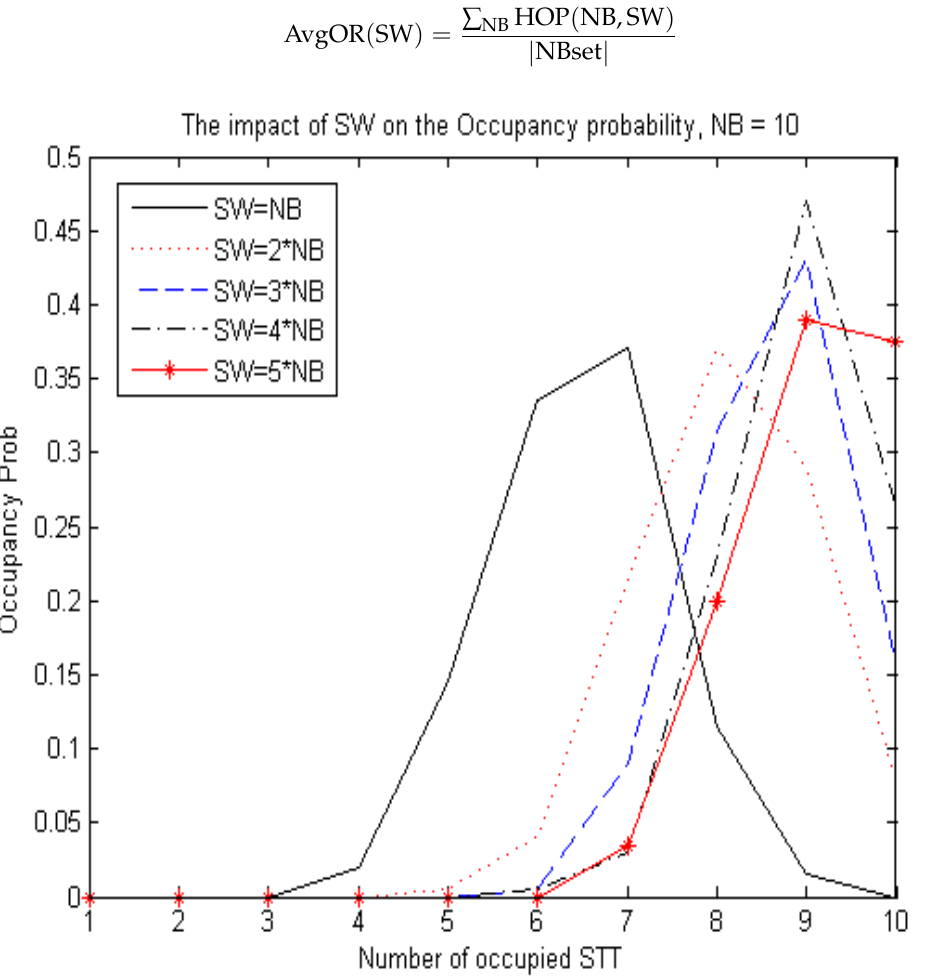
Figure 3. Impact of the SW size on the occupancy possibilities and on the HOP, for a number of beacons equal to 10.